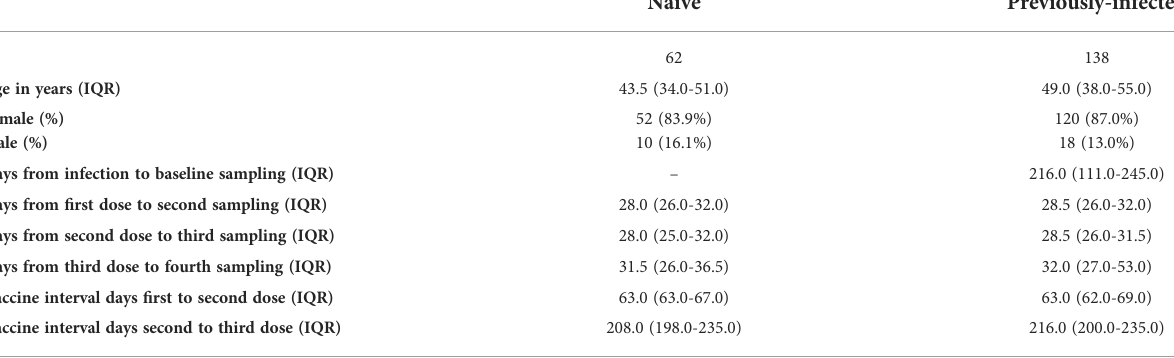
TABLE 1 Characteristics of healthcare workers included in the study. Values are shown in median + interquartile